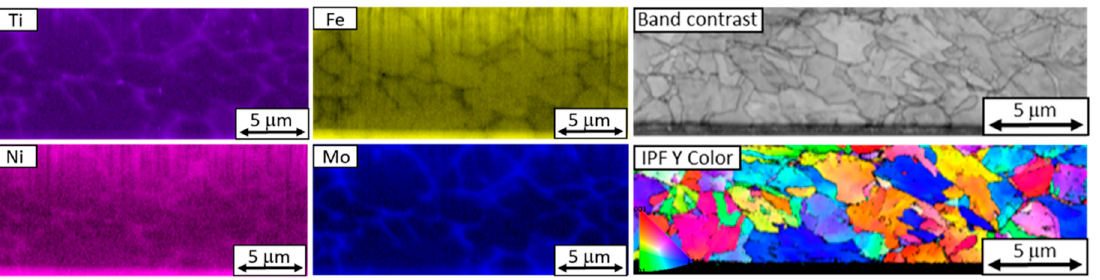
Figure 7. EDS and EBSD images of a section through a virgin powder particle with chemical segregation along the boundaries of its structural units. A band contrast map and an IPF map reveal the grain structure of the particle.